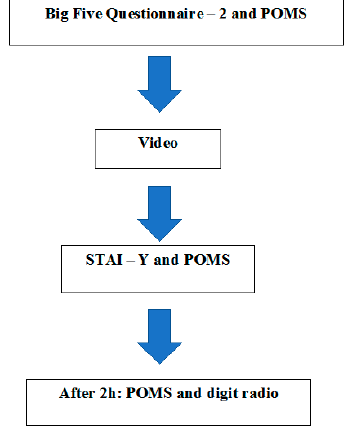
Figure A1. Protocol of research.